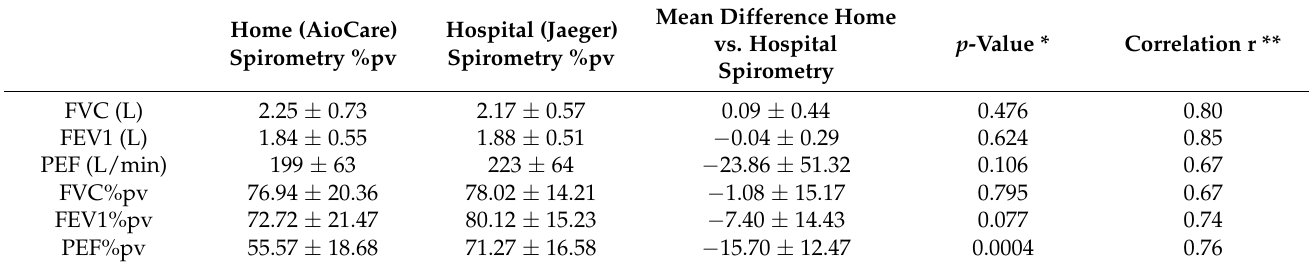
Table 4. Difference between home (AioCare) vs. hospital (Jaeger) spirometry for the entire study group. Home (AioCare) Spirometry